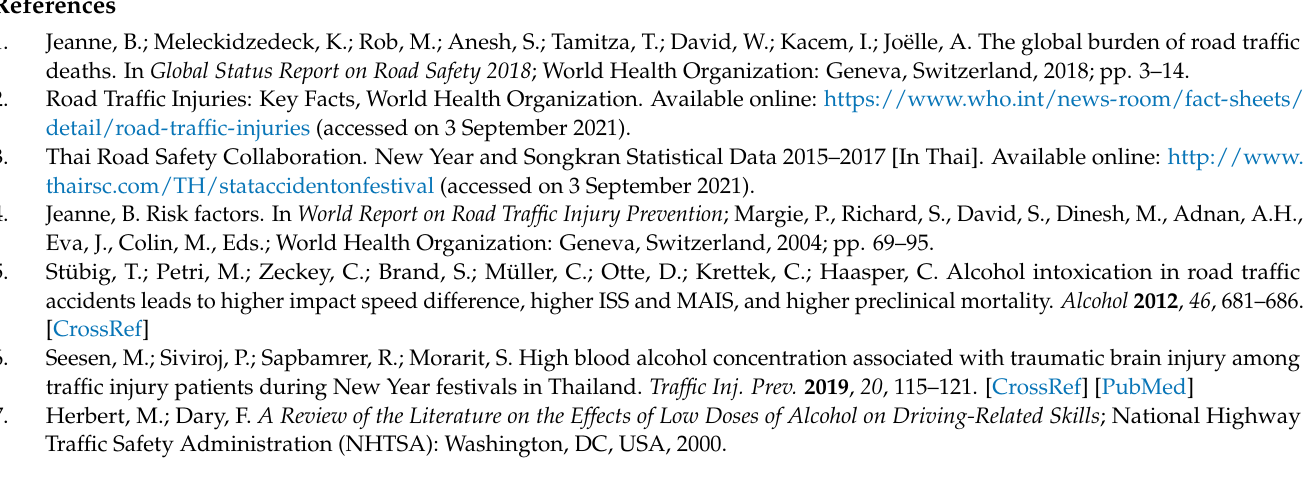
discrimination performance of mortality prediction models using imbalance data, Figure S1: Receiver Operating Characteristic curves from 10-fold cross-validation of the imbalanced learning classifiers, Figure S2: Calibration plot of the imbalanced learning